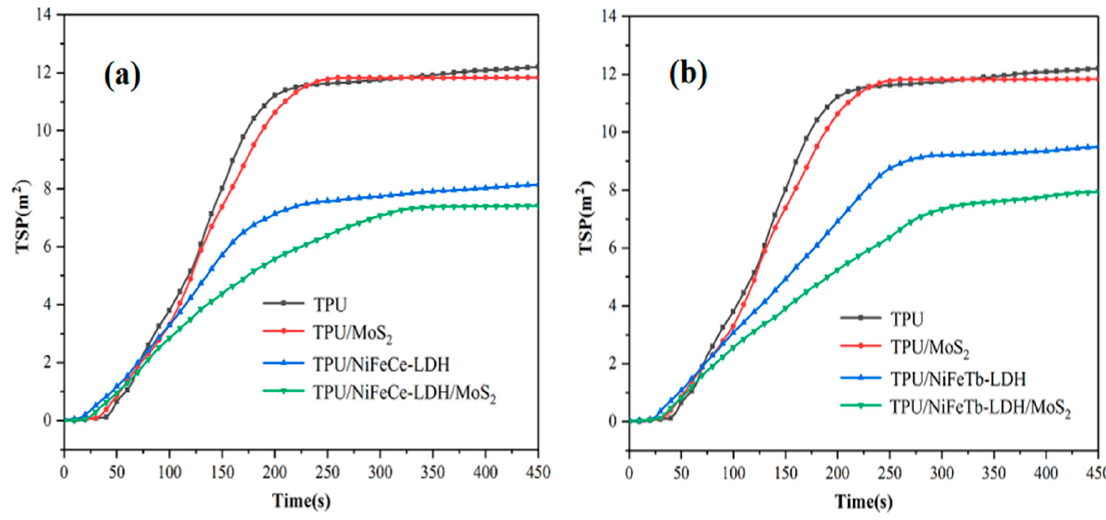
Figure 9. TSP curves of pure TPU and TPU composites ( a,b ).